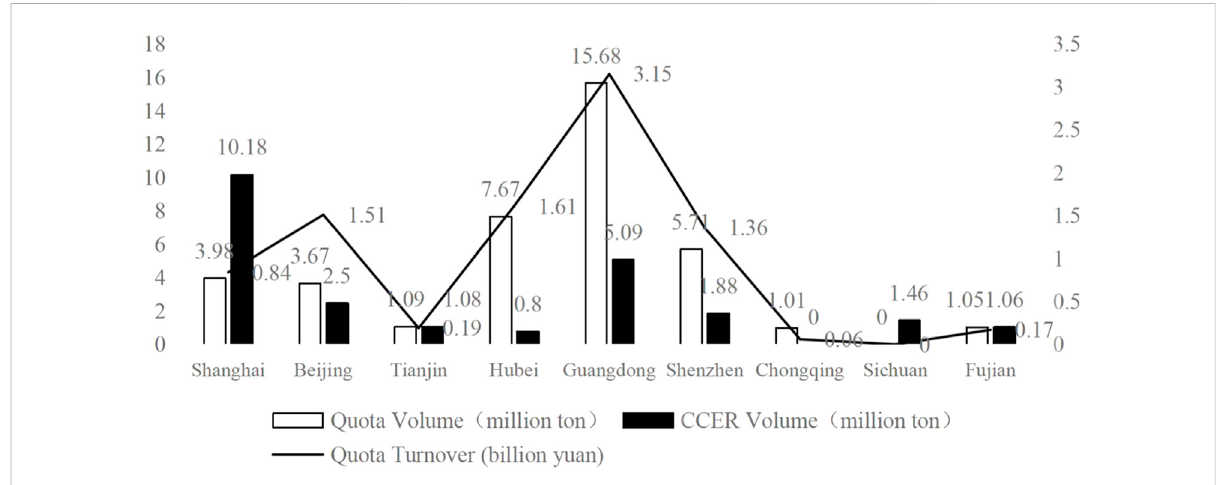
FIGURE 3 CarbonemissionstradinginpilotmarketsnationwideasofAugust2020.Source:Carbonemission